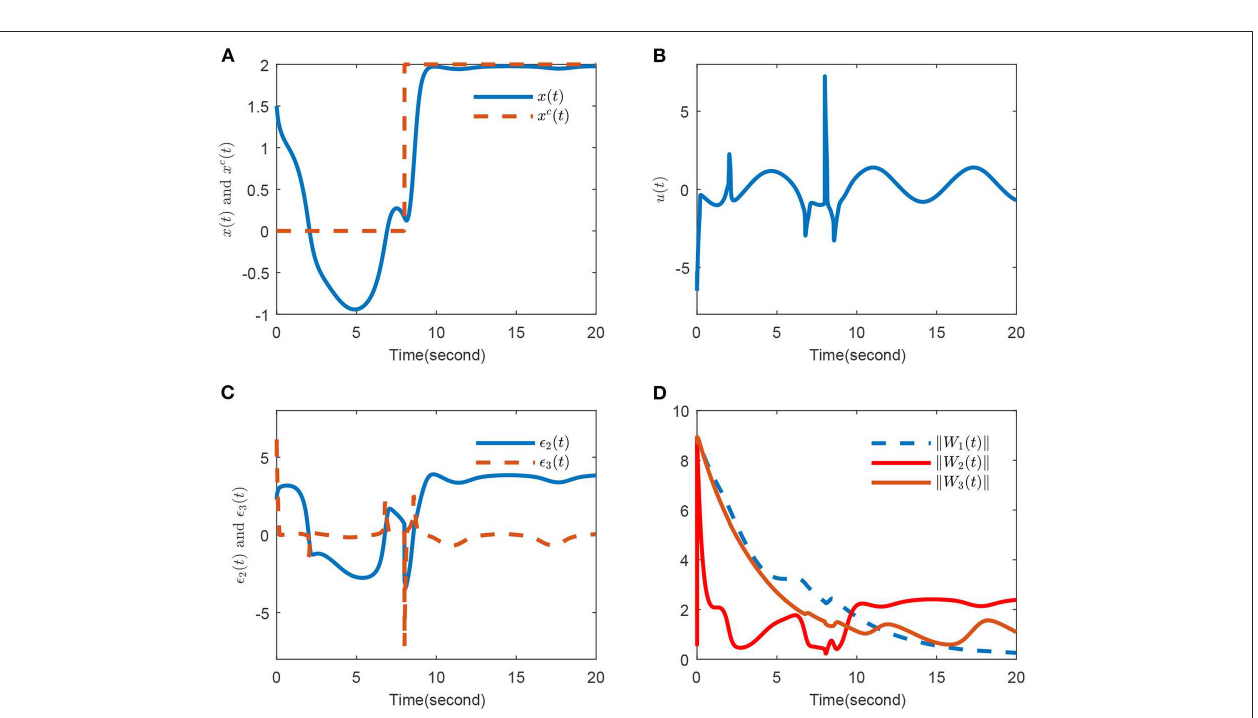
Frontiers in Physics |